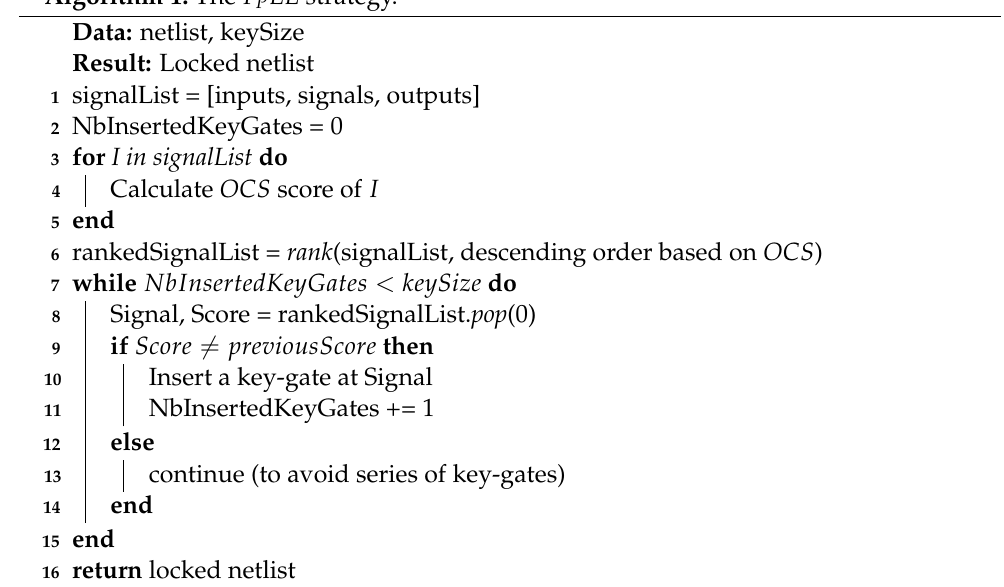
Algorithm 1: The F P LL